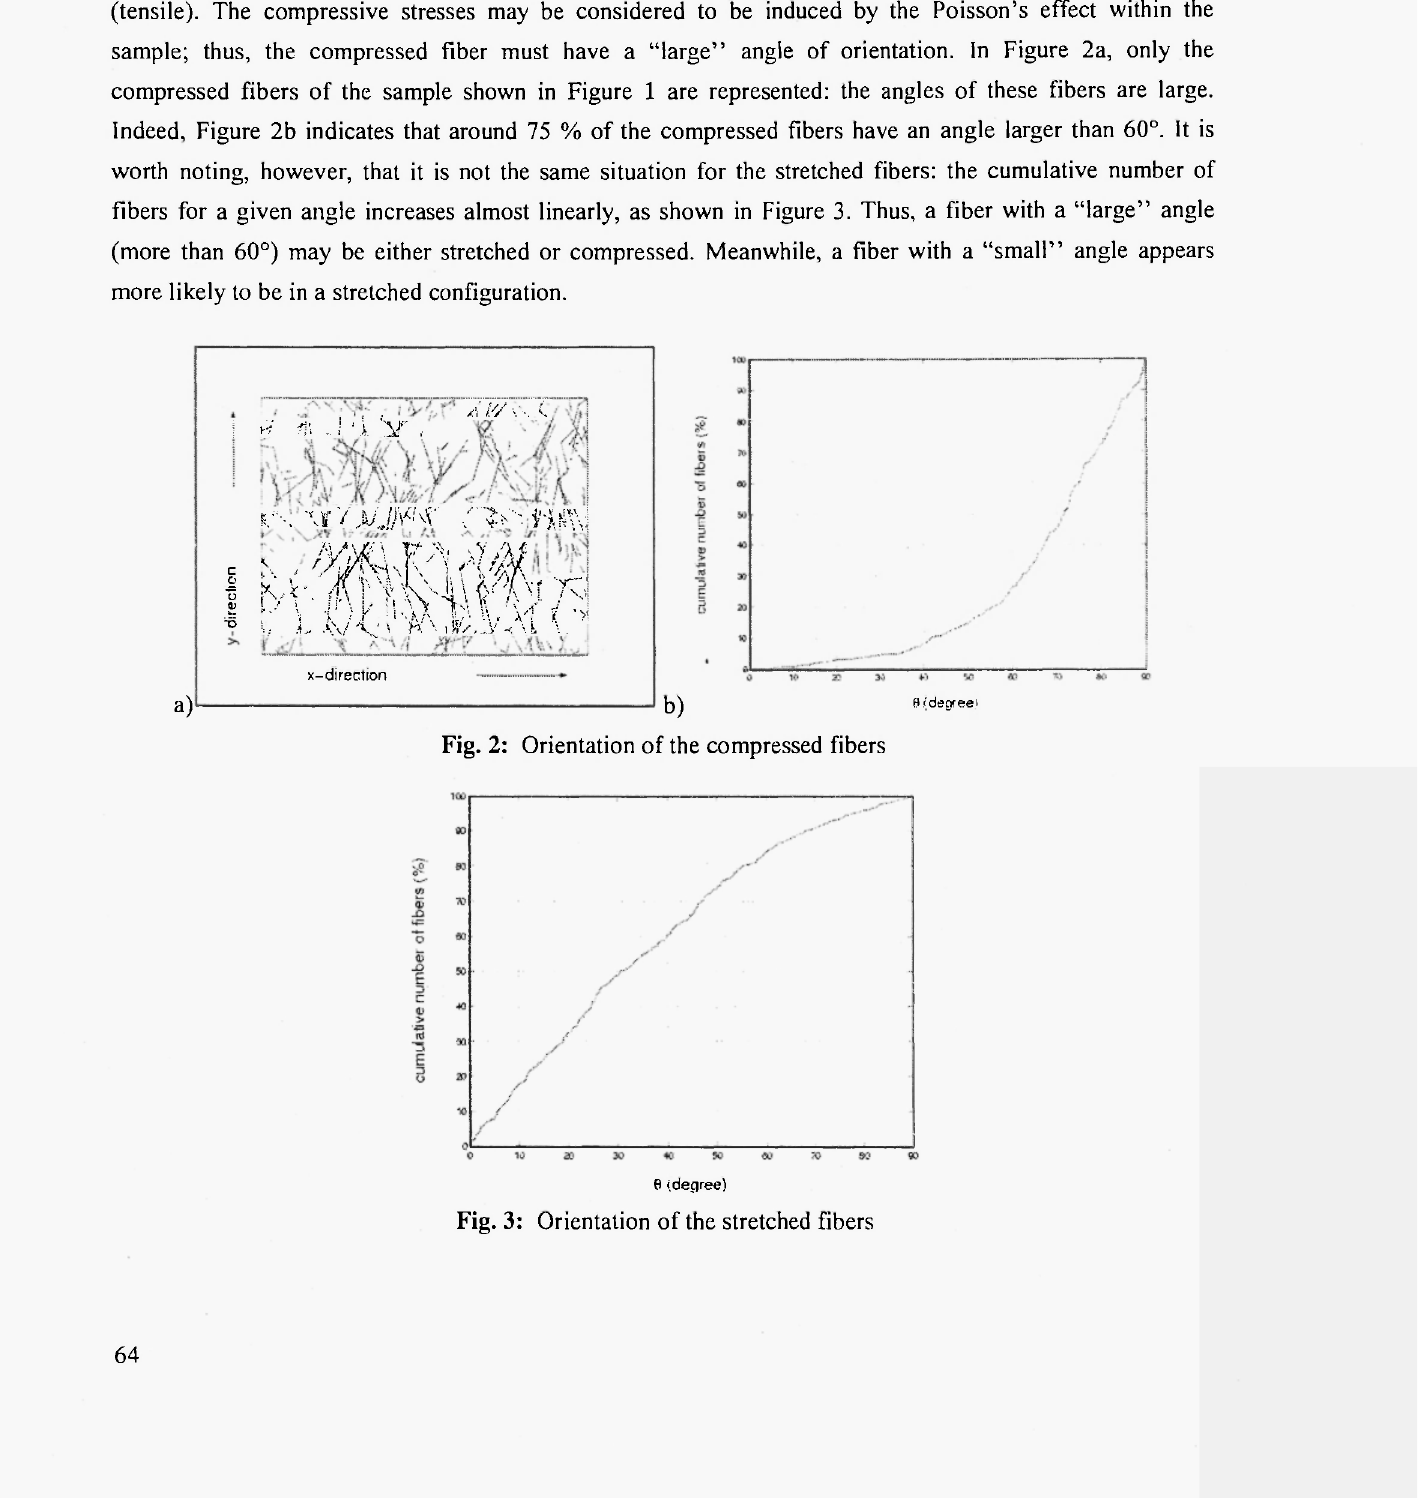
Fig. 3: Orientation of the stretched